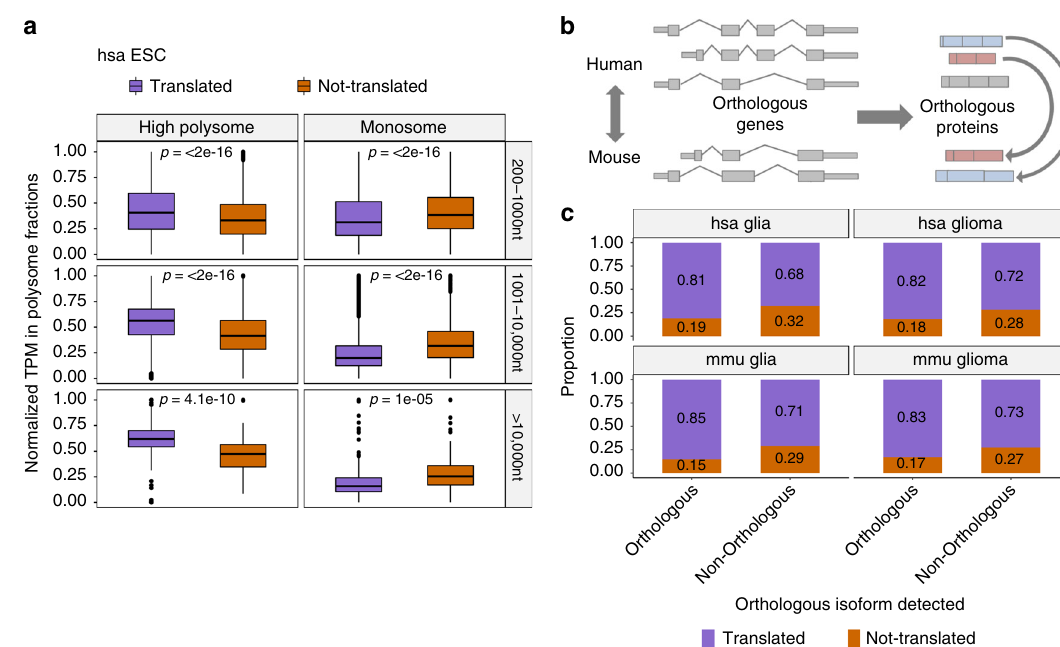
Fig. 2 Validation of predictions. a We show the distribution of the relative abundance in high polysome (left panels) and monosome (right panels) fractions of human embryonic stem cells (ESC) for translated isoforms and for isoforms with RNA expression (TPM > 0.1) but predicted as not-translated. The plot shows the results for three different ORF lengths: 200 – 1000nt (high polysome Wilcoxon test p -value 7.2e – 67, translated n = 18,056 and not- translated n = 9397, and monosome Wilcoxon test p -value 2.3e – 77, translated n = 15,023 and not-translated n = 8277), 1001 – 10000nt (high polysome Wilcoxon test p -value 2.5e – 242, translated n = 19,169 and not-translated n = 3813, and monosome Wilcoxon test p -value 1.1e – 94, translated n = 16,002 and not-translated n = 3179), and longer than 10000nt (high polysome Wilcoxon test p -value 5.1e – 10, translated n = 200 and not-translated n = 69, and monosome Wilcoxon test p -vaue 5e – 06, translated n = 178 and not-translated n = 66). The results for neuronal cells are given in Supplementary Fig. 3. Box boundaries correspond to the fi rst and the third quartiles, the median is indicated by a thick black line, top and bottom whiskers extend up to 1.5 times the interquartile range to the highest and smallest values, respectively, and outliers are indicated as black dots. b Cross-species conservation of protein isoforms. Protein isoforms from each 1-to-1 orthologous gene pair are compared, and candidate orthologous pairs are assigned using an optimization approach (see the “ Methods ” section). c For the set of ORFs encoding a human – mouse orthologous protein pair (orthologous) and for those encoding proteins without an orthologous pair in mouse (non-orthologous), we plot the percentages that are predicted to be translated (translated) and the ones with RNA expression (TPM > 0.1) but predicted as not-translated (not-translated). We show here the results for human glia (Fisher ’ s test p -value = 1.41e – 140, orthologous n = 12,801 and non-orthologous n = 17,111) and glioma (Fisher ’ s test sp-value = 3.63e – 85, orthologous n = 12,453 and non- (Fisher ’ s test p -value = 7.462e – 53, orthologous n = 12,015 and non-orthologous n = 5905). Other mouse samples are shown in Supplementary Fig.